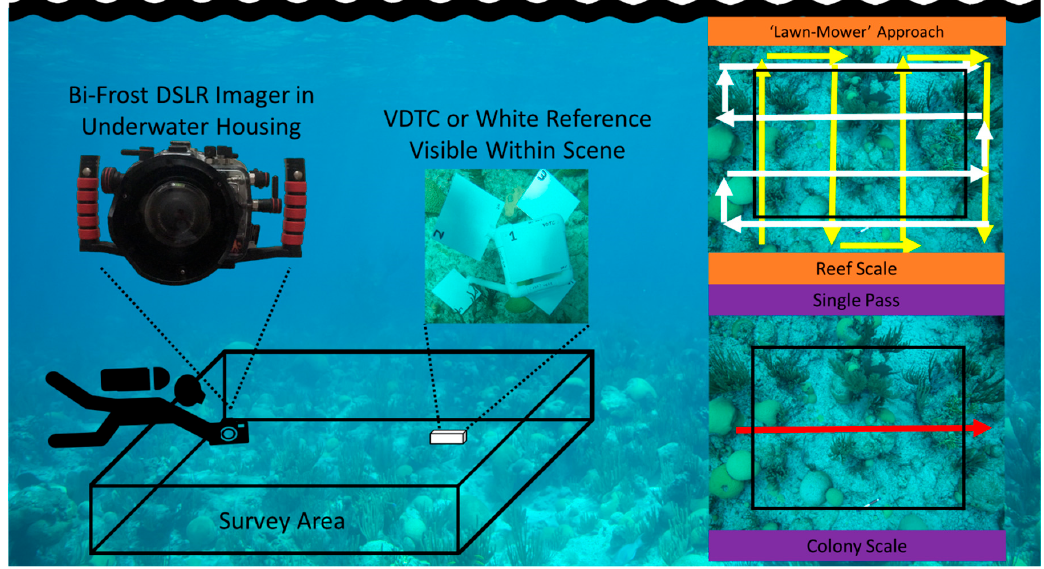
Figure 2. The survey method for the Bi-Frost DSLR hyperspectral imager can either be conducted in a ‘lawn mower’ approach [77] for reef scale surveys or a single line pass for colony scale surveys. To ensure sufficient coverage data, the recorded area must exceed the target survey area. Water attenuations effects are corrected for by imaging white reference objects at various depths. These are variable depth target calibrators (VDTCs) that comprise a series of white references at different depths or a single white reference (only for correcting against incident light where variable depth is not considered).